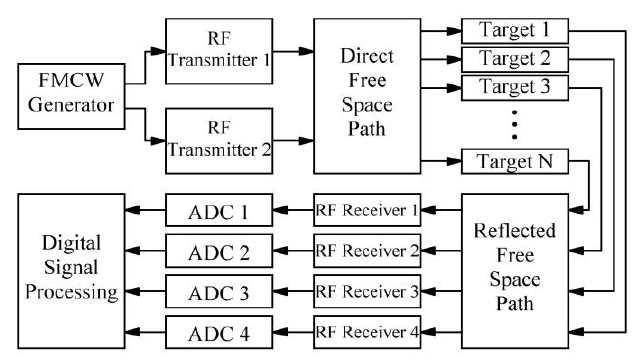
Fig. 3. First-level model block